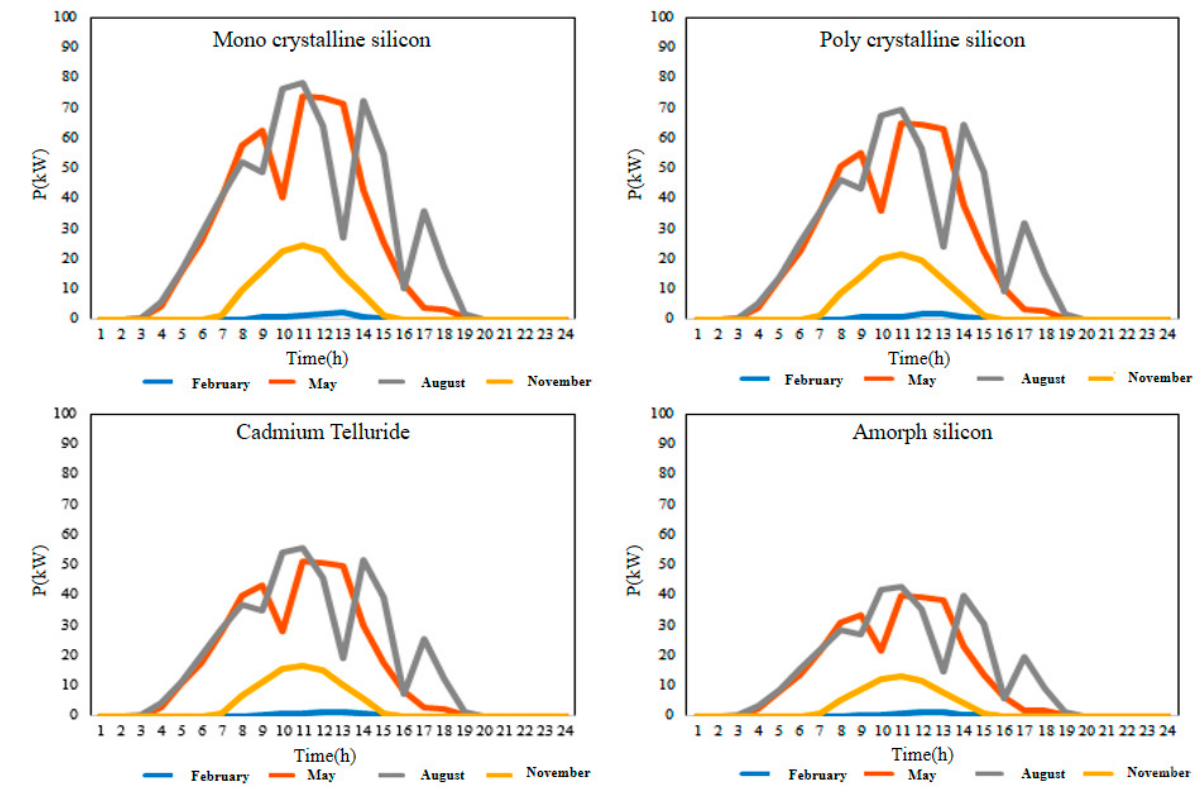
technology in each month.